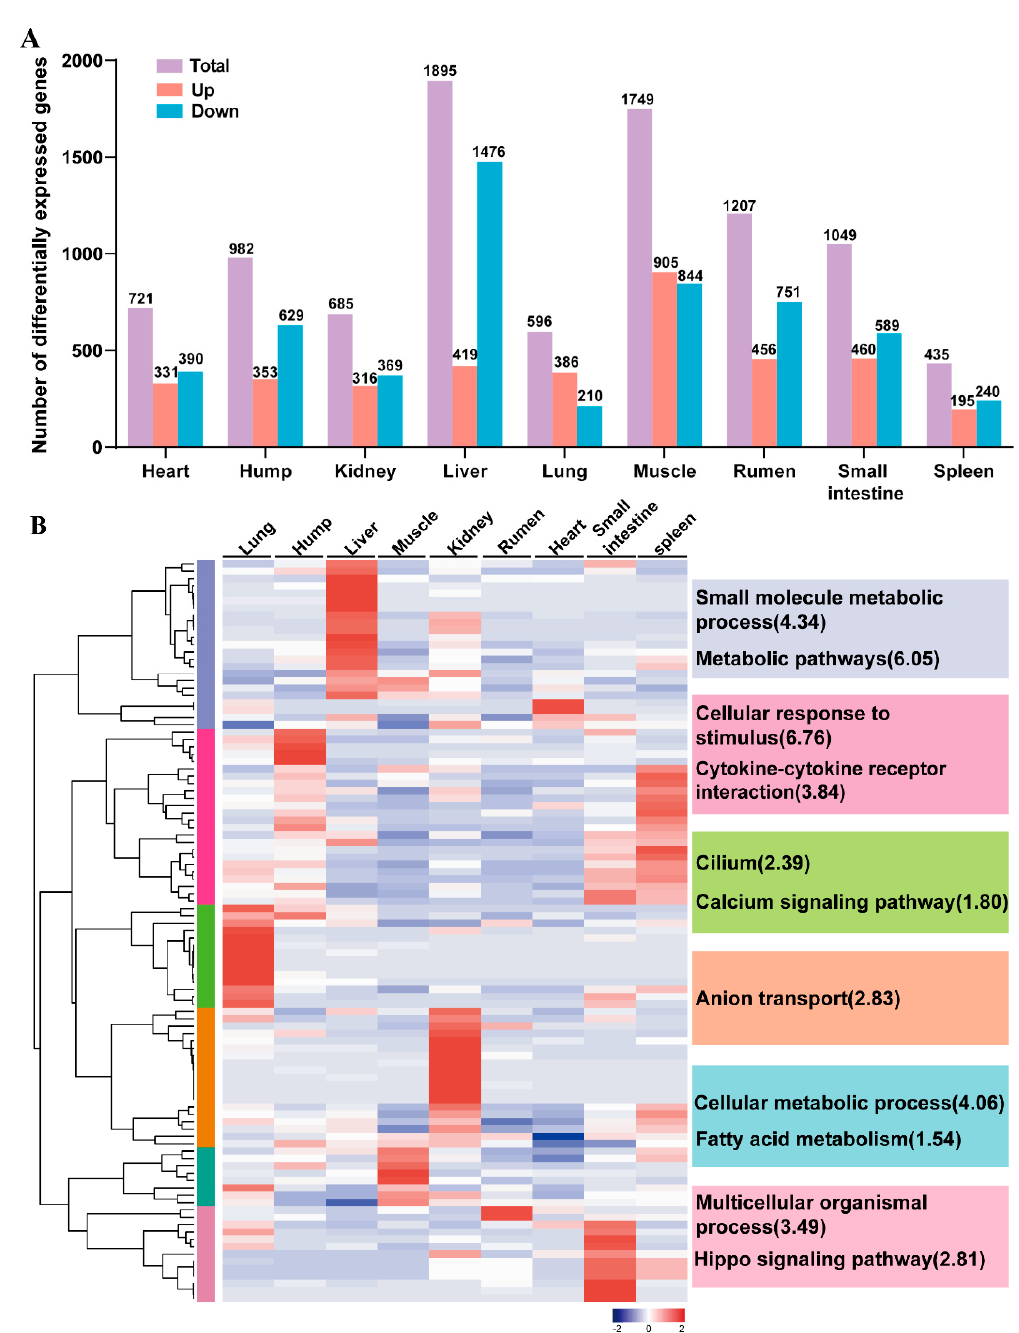
Figure 3. Expression of development-associated genes in Bactrian camels. ( A ) Number of differ- entially expressed genes between adults and fetuses. The criteria for differential expression were false-discovery rate < 0.05, fold-change > 2, and FPKM > 1. ( B ) Expression profiles of 101 genes with significantly and uniquely enriched GO terms and KEGG